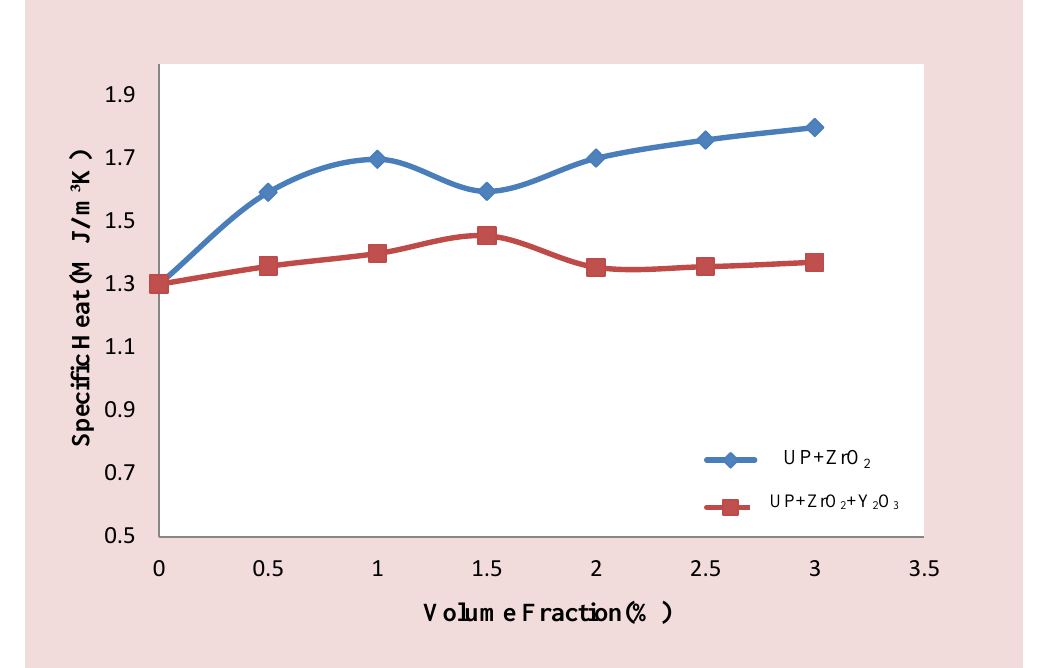
Fig .7: Volumetric specific heat of the (UPE) nanocomposites as a function of the volume fraction of nanoparticles and hybrid nanoparticles content in the composite